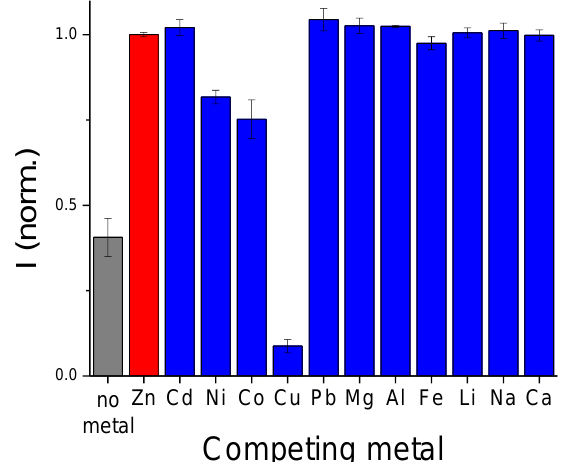
Figure 8. Fluorescence competition assay illustrating the influence of other metals (1 eq.) in the detection of Zn 2+ ions (1 eq.) (blue). Emission intensity of 1 in the absence of any metal (grey) or in the presence of 1 eq. of Zn 2+ (red) was added for comparison. Conditions: MeOH:MOPS 10 mM pH7 (50:50); λ exc = 620 nm.